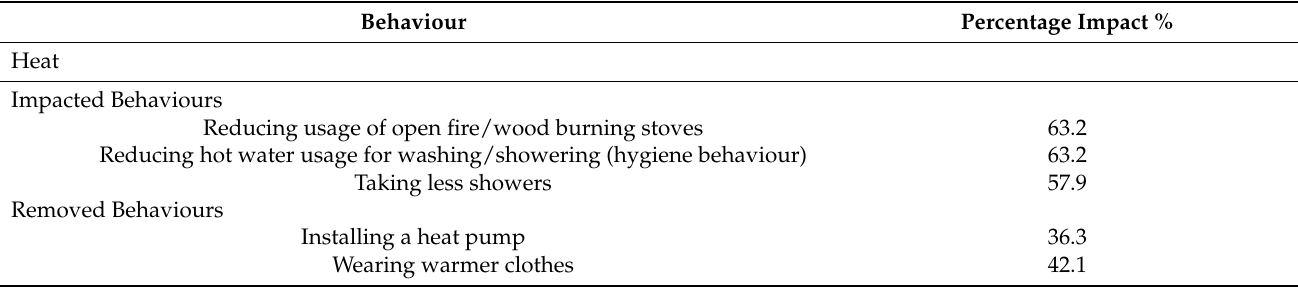
Table 3. Additional climate change mitigation behaviours (identified in Round 1 and rated in Round 2) identified as ‘impacted’ by COVID-19 (over 50% of experts indicated behaviour has been impacted), behaviours removed/not progressed to Round 3 (below 50% of experts indicated be- haviour has been impacted by COVID-19) and percentage value of panellists that indicated respective behaviours were impacted by